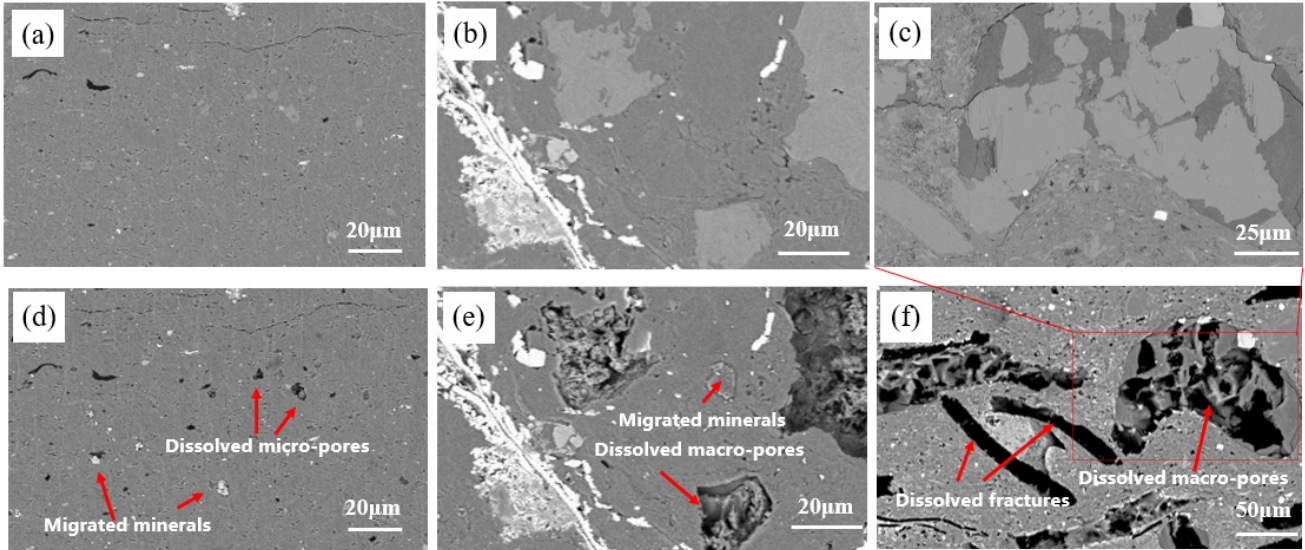
Figure 7. SEM analysis results before and after CO 2 treatment: ( a ) foliaceous shale before treatment; ( b ) laminated feisic shale before treatment; ( c ) laminated diamictic shale before treatment; ( d ) foliaceous shale after treatment; ( e ) laminated feisic shale after treatment and ( f ) laminated diamictic shale after treatment.